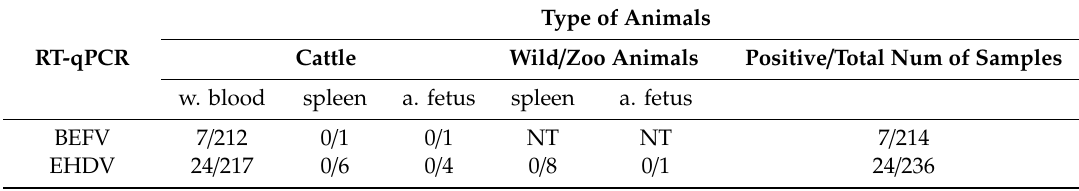
Table 1. Routine molecular diagnostic investigation of field Israeli samples collected from ill and dead animals in 2017 for viral RNA presence of Bovine ephemeral fever virus (BEFV) and hemorrhagic disease virus